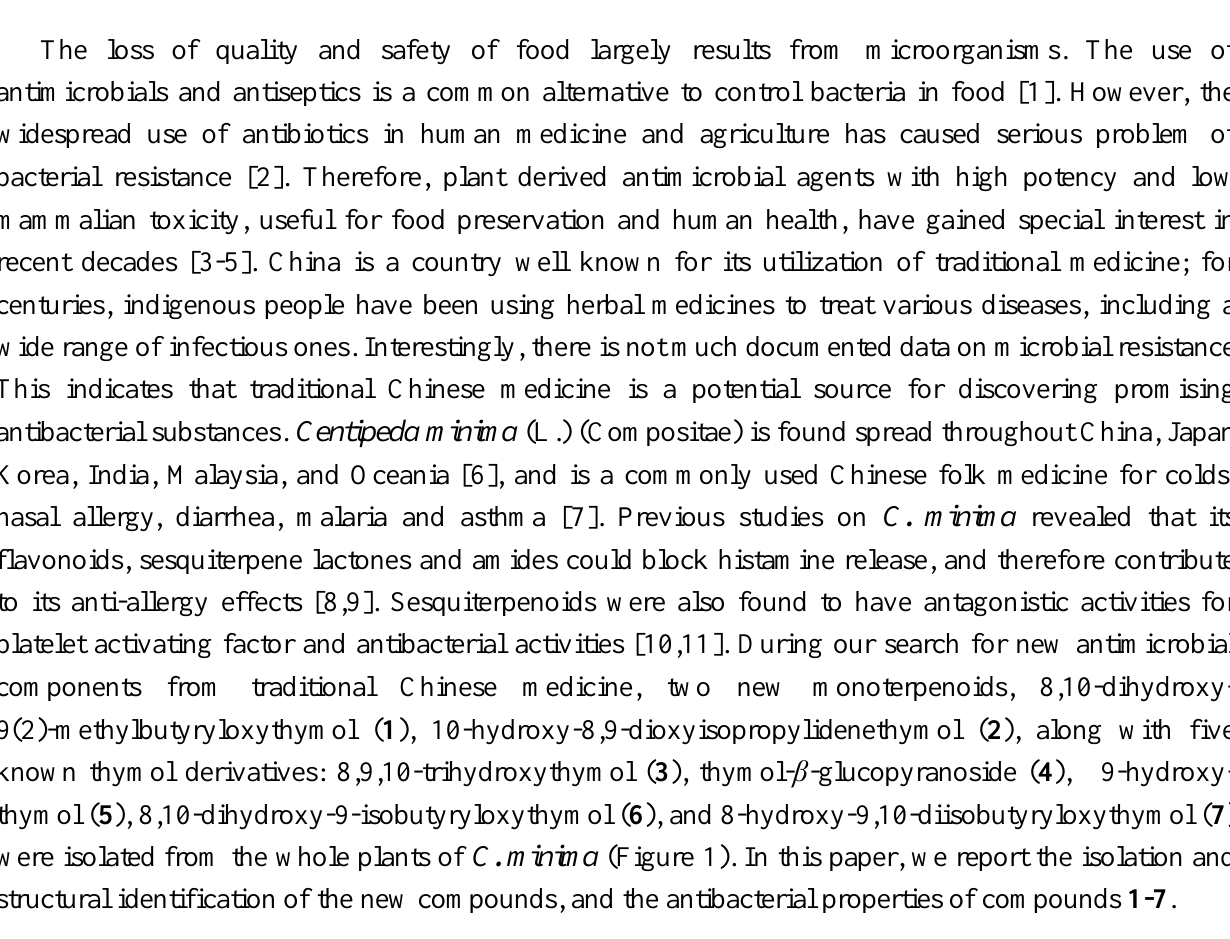
Figure 1. Structures of compounds